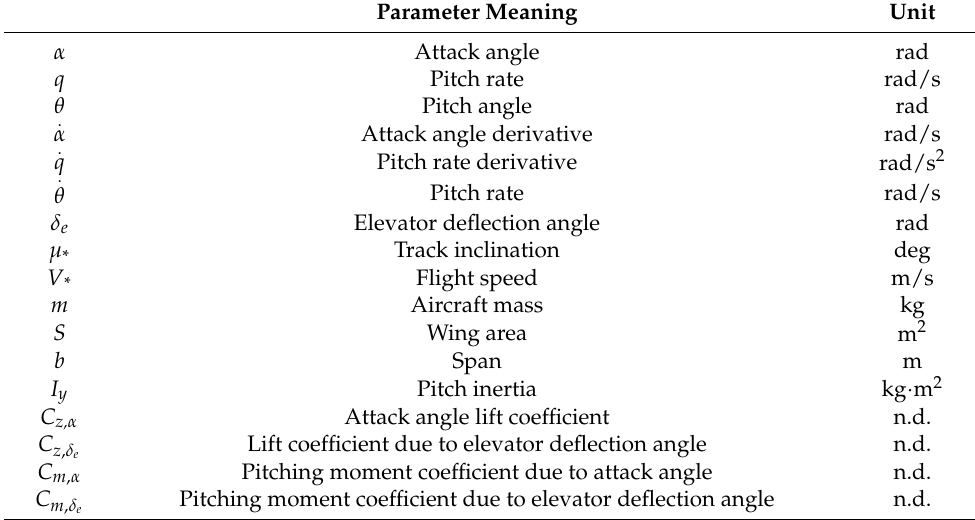
Table 1. Variable meaning